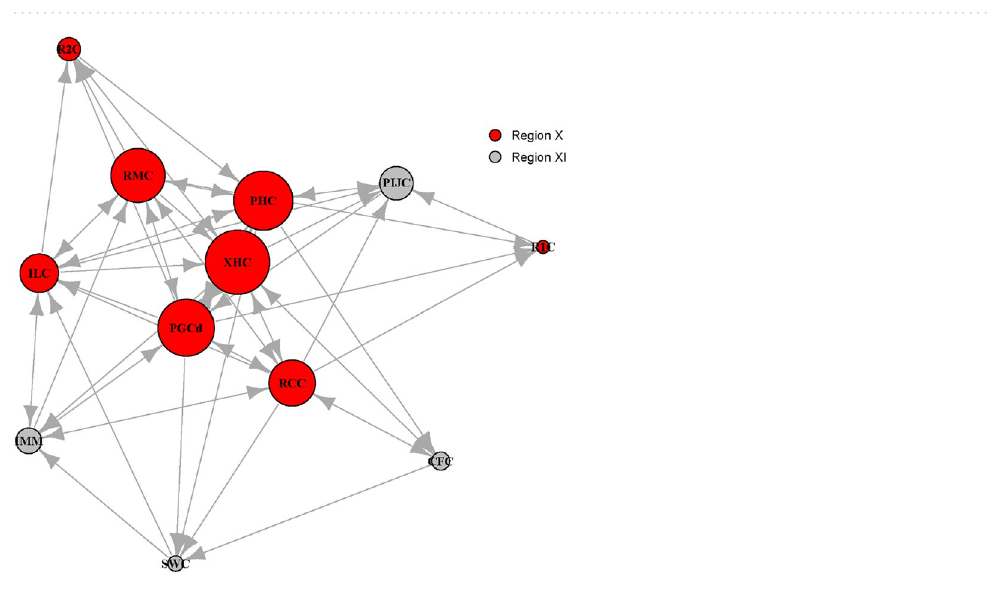
Figure 4. Network plot of individuals’ dispersion between regions. Size of bubble is proportional to number of (im)migrants. For complete locality names and additional information, see Fig. 1 and Table